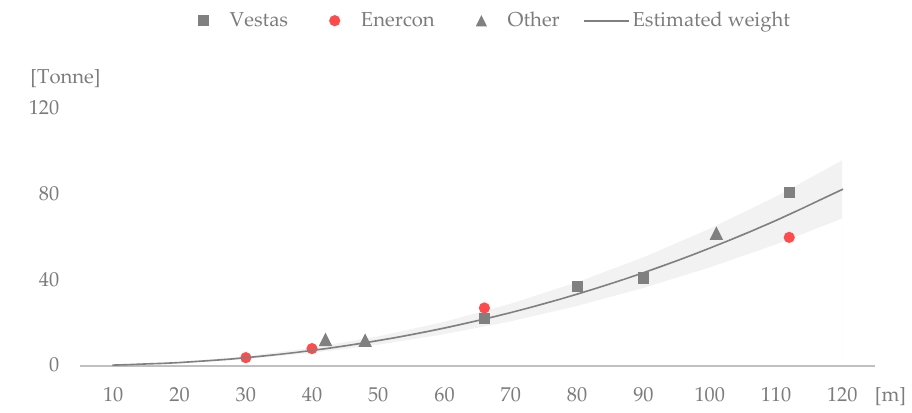
Figure B1. Rotor mass vs. rotor diameter. The grey line represents the output from Equation (2), and the grey and red markers show actual rotor masses gathered from